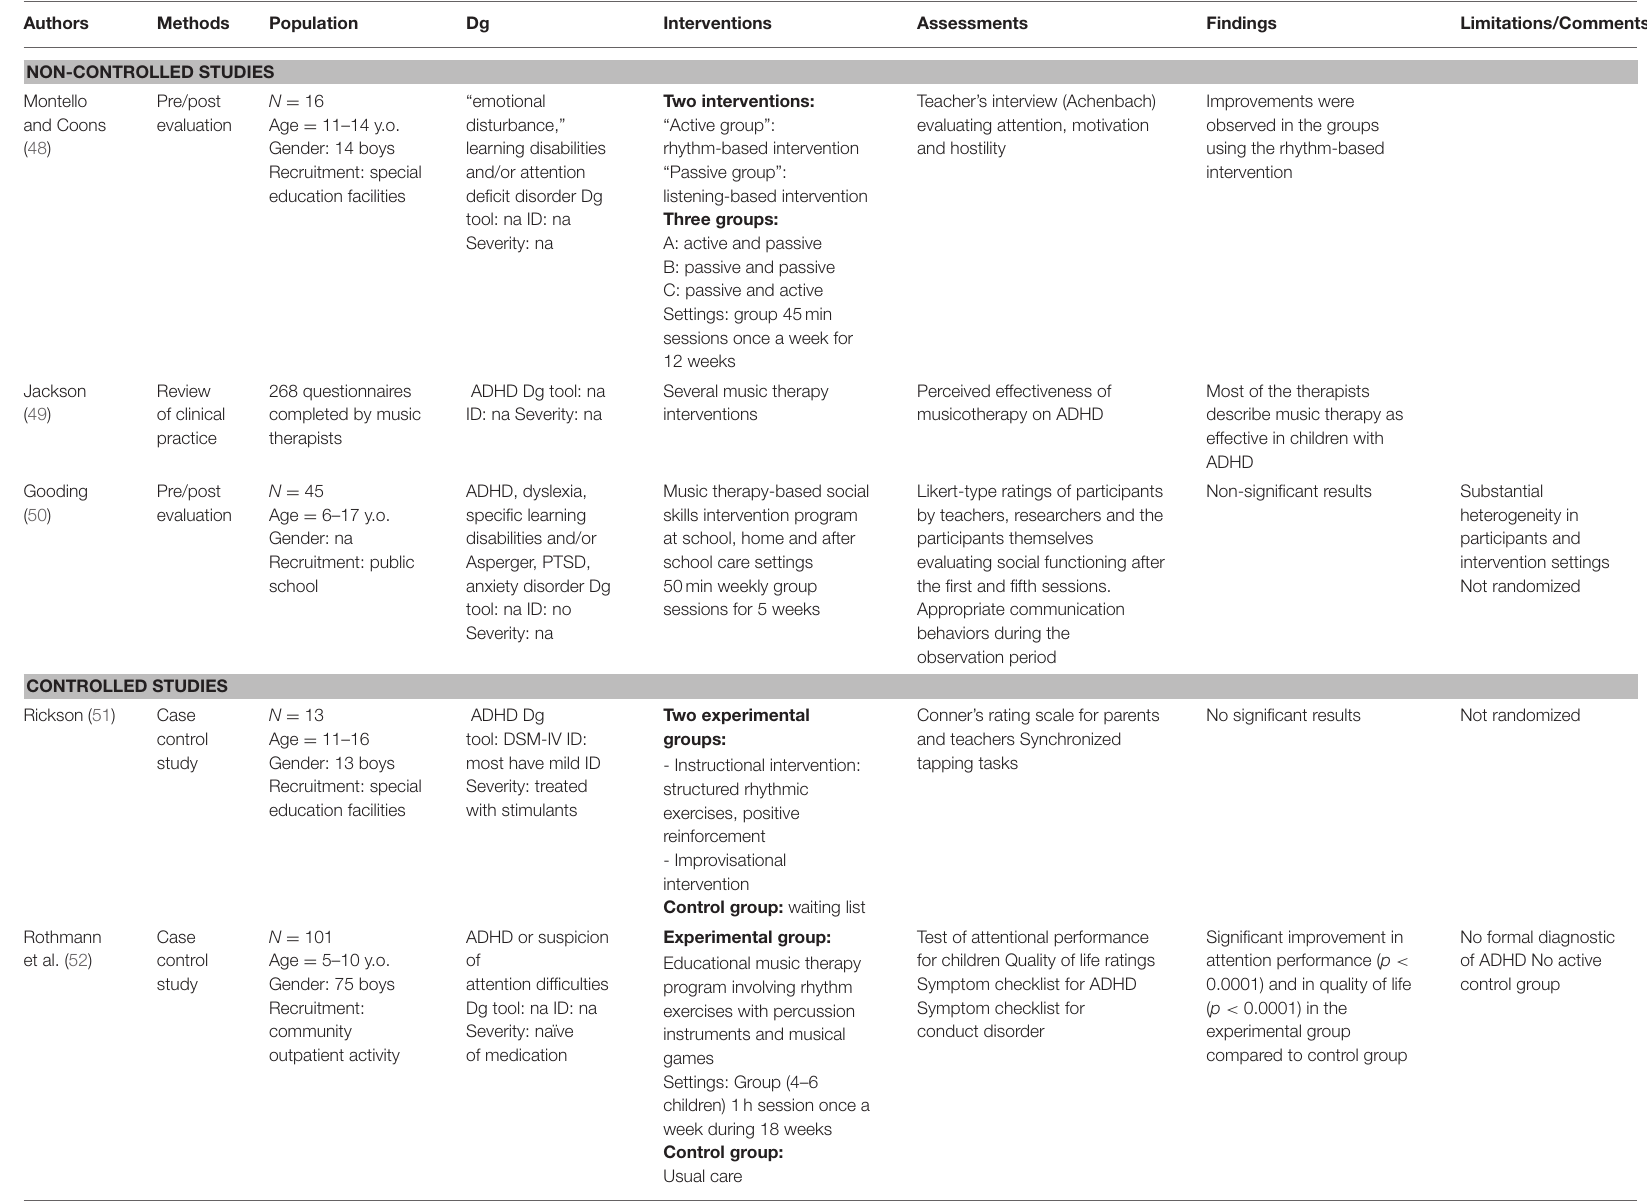
TABLE 4 | Studies assessing musicotherapy in youths with attention deficit hyperactivity disorder